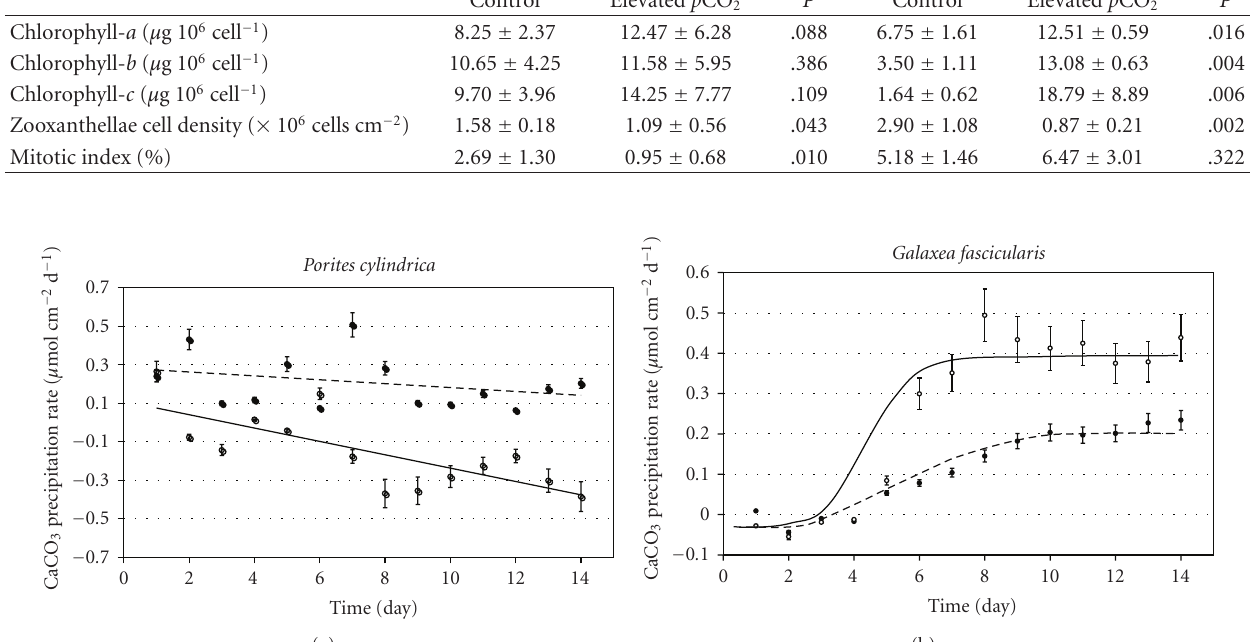
Table 2: Chlorophyll pigments, zooxanthellae cell density, and mitotic index of P. cylindrica and G. fascicularis (mean ± standard deviation) under control and elevated p CO 2 . Each reading was based on six coral nubbins analysed at the end of the experiment. Pair t -test was conducted to compare the parameters under control and elevated p CO 2 . Bolded figures indicate a significant di ff erent and vice versa. P. cylindrica